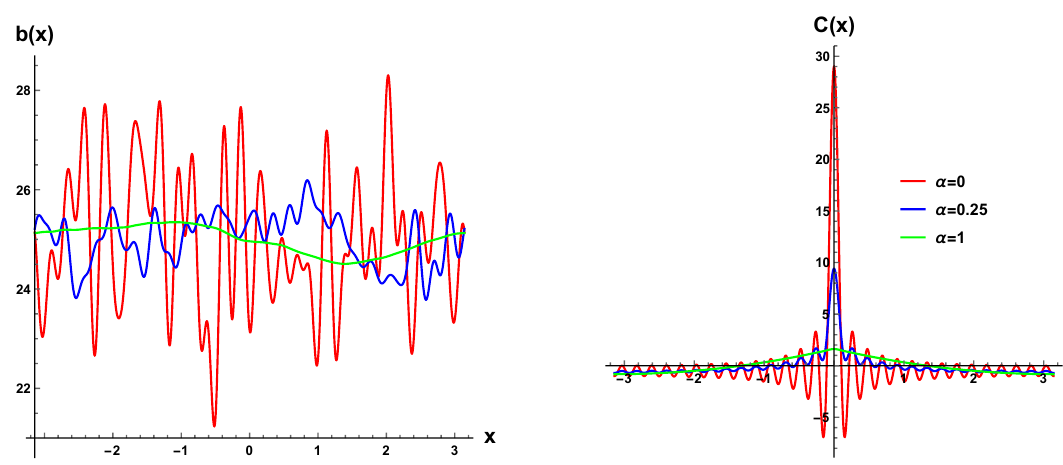
Figure 3 . Left: example of speci(cid:12)c disorder realizations (2.10) with b 0 = 25, N = 30 and (cid:11) = 0 ; 0 : 25 ; 1 (red, blue, green). Right: corresponding correlation functions C ( x